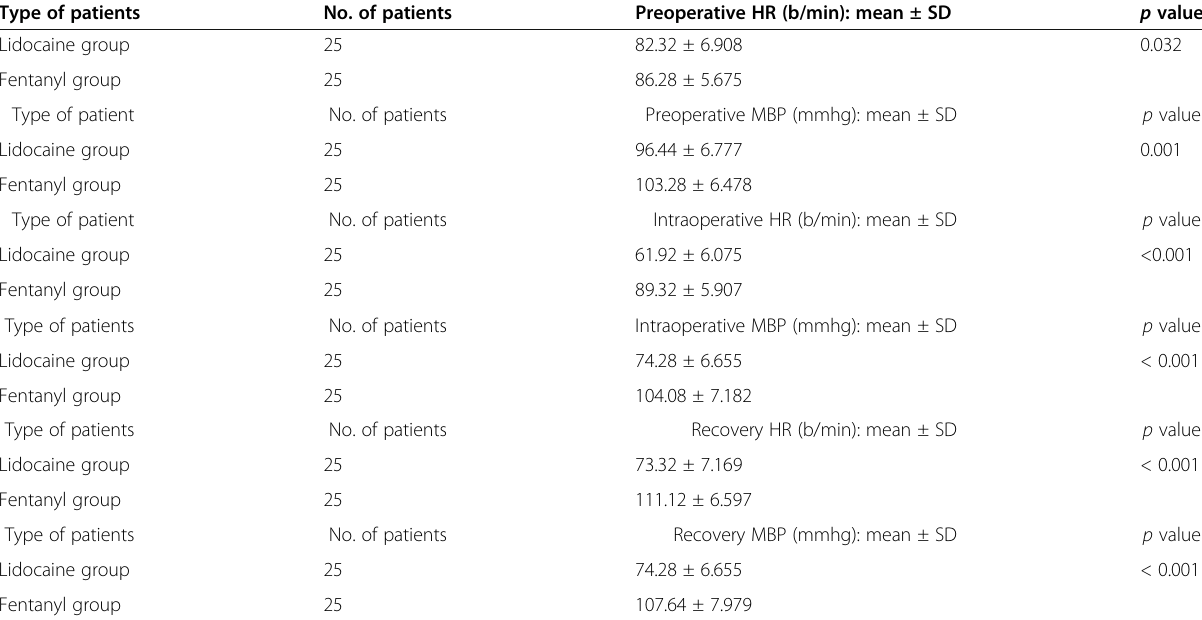
Table 6 Preoperative (heart rate HR and mean blood pressure MBP)/intraoperative (heart rate HR and mean blood pressure MBP)/ recovery (heart rate HR and mean blood pressure